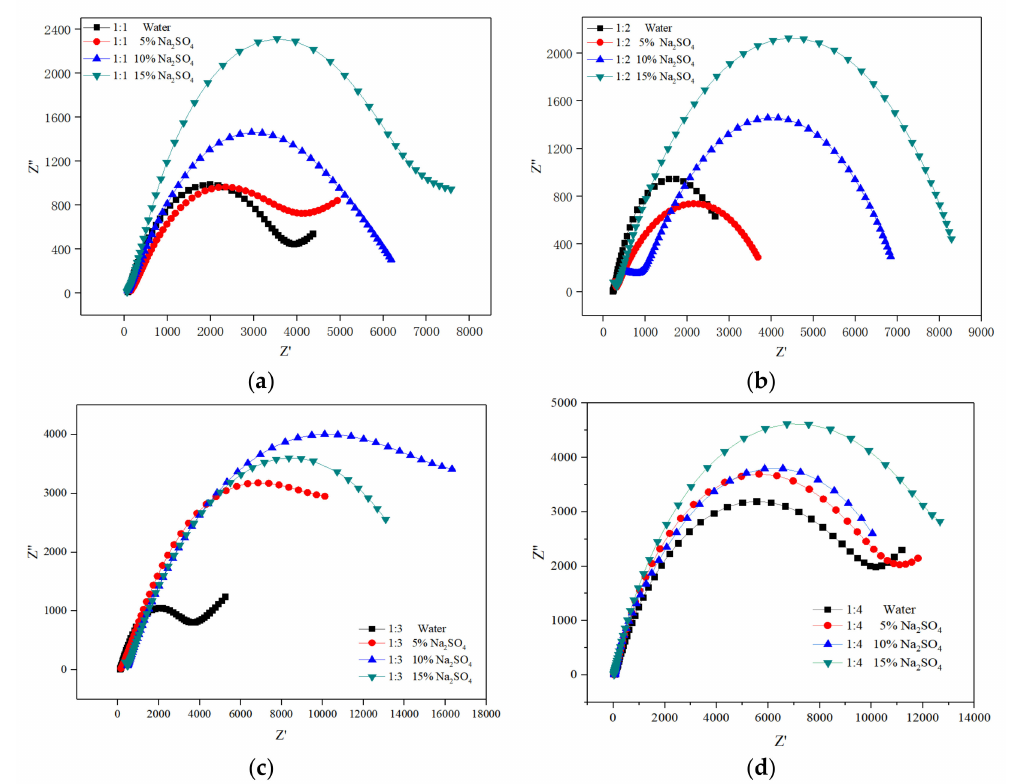
Figure 9. Nyquist at di ff erent high-sulphur fly ash contents. ( a ) 50% high-sulphur fly ash, ( b ) 66.7% high-sulphur fly ash, ( c ) 75% high-sulphur fly ash, ( d ) 80% high-sulphur fly